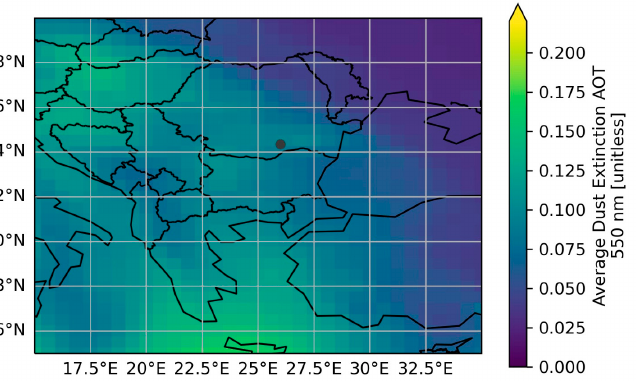
Figure 11. Average dust extinction AOT over the 8–11 June 2018 period provided by MERRA-2 reanalysis (source: https://giovanni.gsfc.nasa.gov/giovanni/ (accessed on 9 March 2021)). The dot shows the location of our ground-based station.